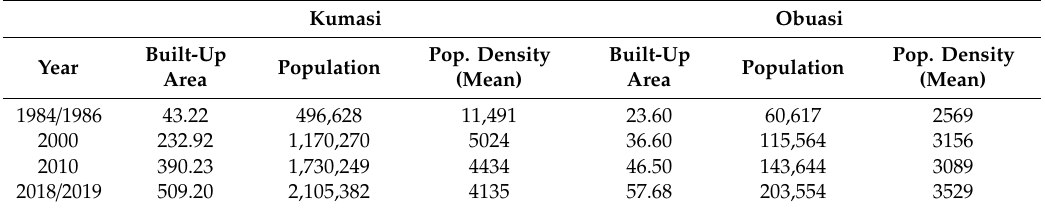
Table 4. Population density (number of people/km 2 ) in Kumasi and Obuasi.